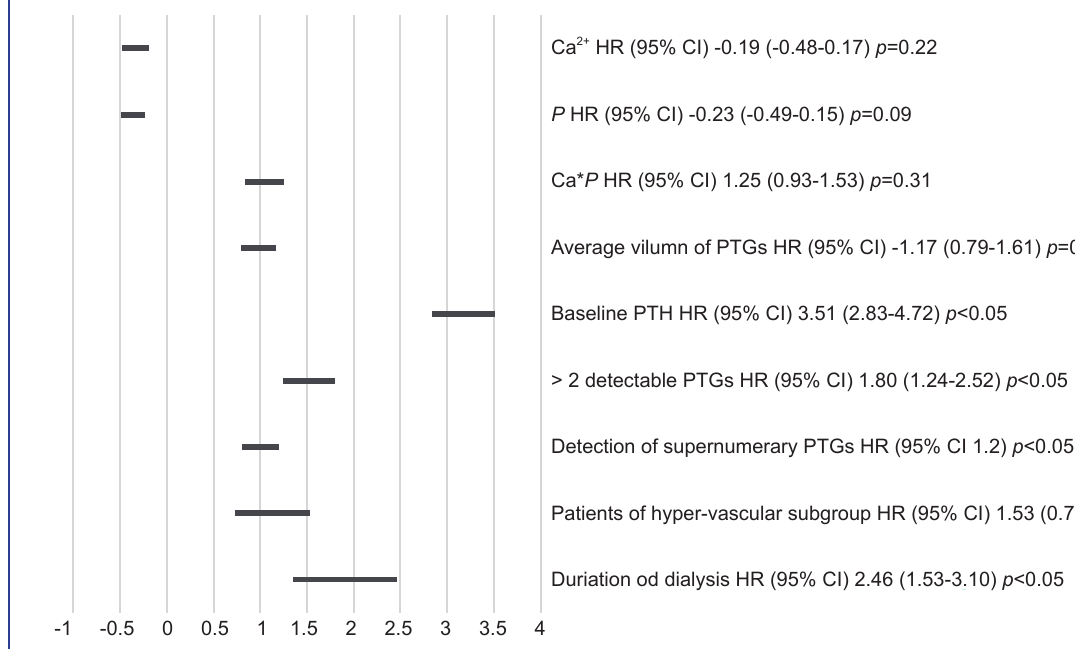
Figure 3 Multiple logistic regression analysis of the association between sonographic features, laboratory examinations and the necessity of surgeries.